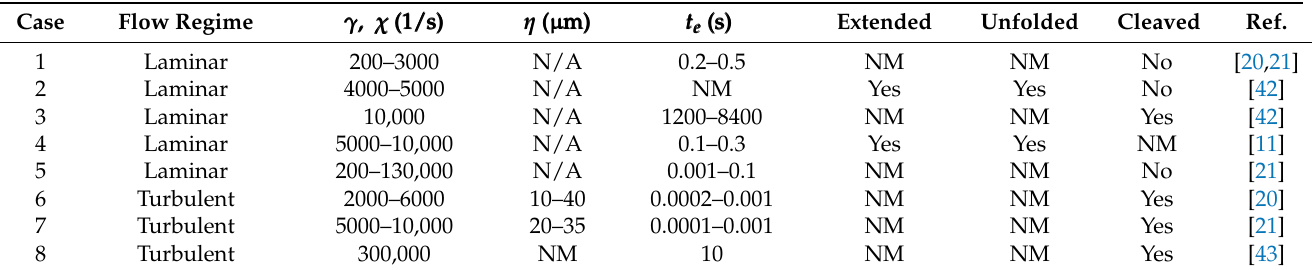
Table 1. Parameters found in experimental studies where, NM: Not measured, N/A: Not applicable, χ : principal strain rate, γ : turbulent flow strain rate, η : Kolmogorov length scale, t e : exposure time. Case Flow